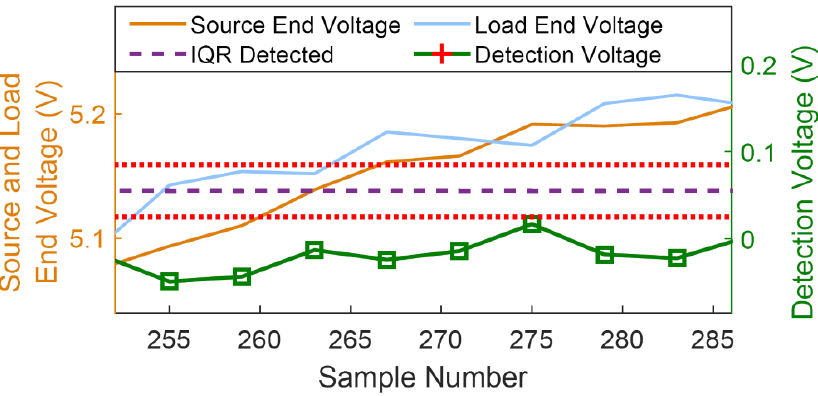
Figure 12. Event 3: detection analysis using the proposed method for a sharp load change event when the voltage at the source end is